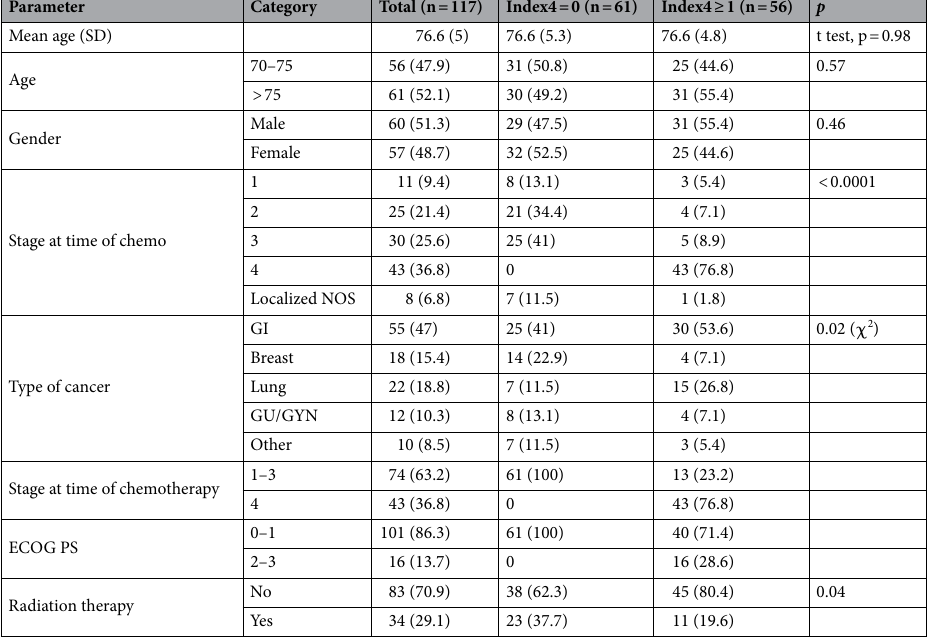
Table 1. Baseline patient characteristics according to the Index4 score. The last column depicts Fisher’s exact test p values except if otherwise specified. BMI Body Mass Index. Stage and ECOG PS are among the parameters for the calculations of Index4 and thus by definition no patients had stage 4 disease or ECOG PS of 2 or 3 in the Index4 = 0 group. Percentages are in parentheses except if otherwise specified.